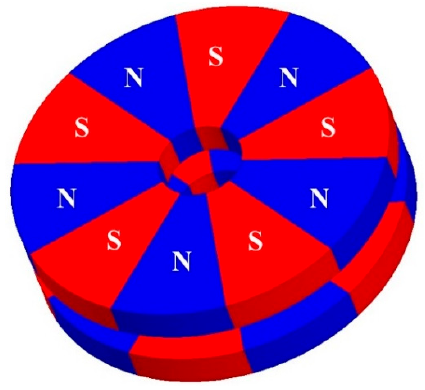
Figure 5. The axial-flux type magnetic coupling used in the proposed LOCH.